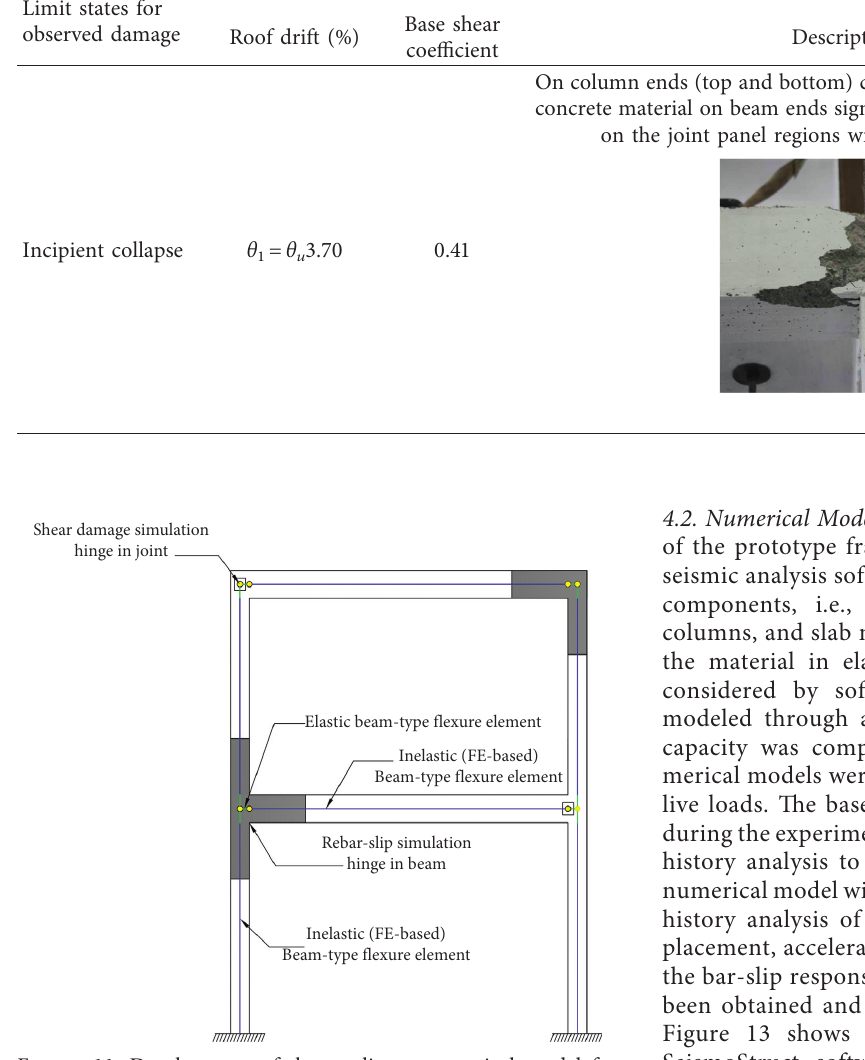
Figure 11: Development of the nonlinear numerical model for frame structures